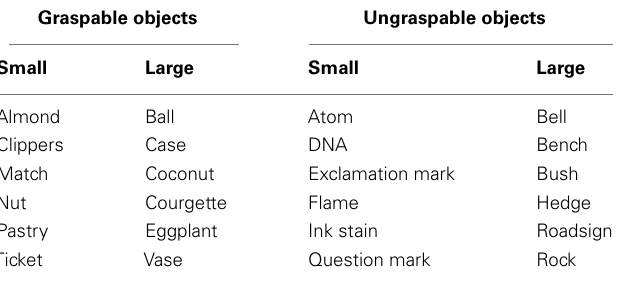
Table 2 |The 24 objects of Experiment 2.